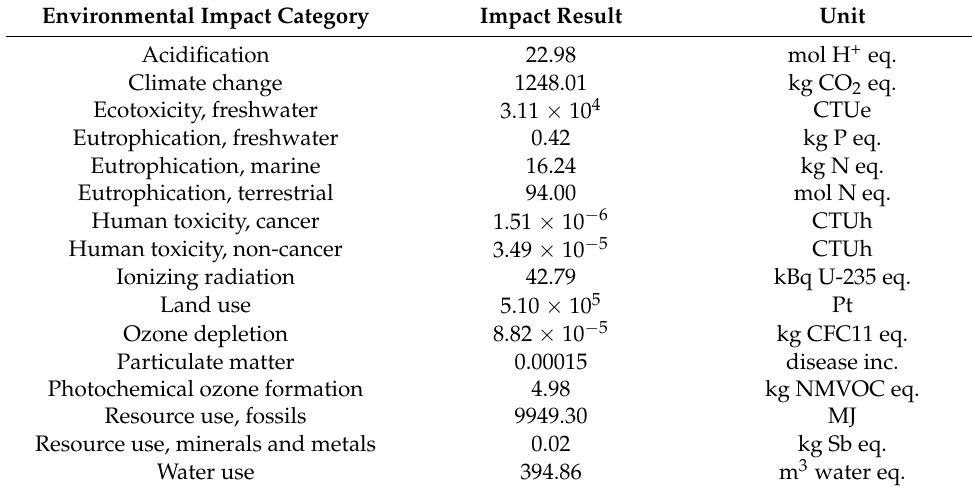
Table 5. Environmental impact of miscanthus cultivation per environmental impact category and ha and